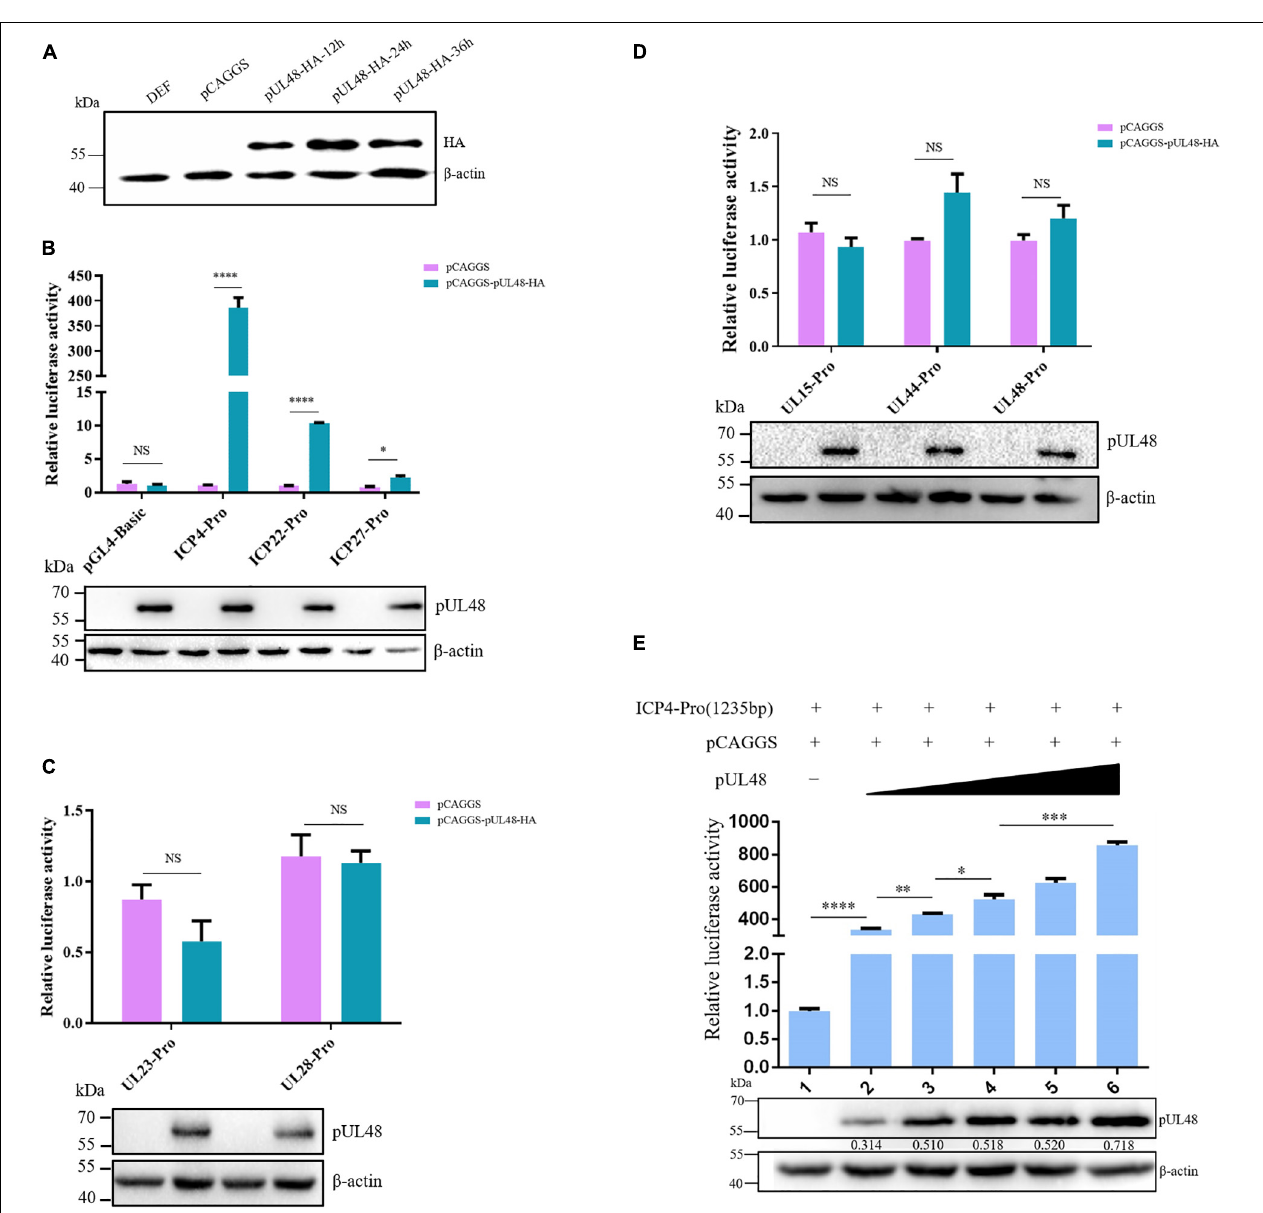
FIGURE 1 | Regulation of pUL48 on duck plague virus (DPV) gene promoters of different types. (A) Expression of pCAGGS-pUL48-HA in DEF. pCAGGS and pCAGGS-pUL48-HA were transfected into DEF, respectively, and cell protein samples were collected at 12, 24, and 36 h for Western blot. (B) The regulation of pUL48 on the IE gene promoter of DPV. (C) The regulation of pUL48 on DPV early gene promoters. (D) The regulation of pUL48 on DPV late gene promoter. (E) Dose-dependent activation of pUL48 on ICP4-Pro (1,235 bp). pGL4-basic, ICP4-Pro-Luc, ICP22-Pro-Luc, ICP27-Pro-Luc, UL23-Pro-Luc, UL28-Pro-Luc, UL15-Pro-Luc, UL44-Pro-Luc, and UL48-Pro-Luc were cotransfected into DEF with pCAGGS, pCAGGS-pUL48-HA, and pRL-TK/0.05, 0.1, 0.2, 0.3, and 0.4 µ g pCAGGS-pUL48-HA were cotransfected into DEF with pCAGGS, ICP4-Pro (1,235 bp)-Luc and pRL-TK. Except for the reference plasmid pRL-TK, the transfection ratio of other plasmids was 1:1:1, and the transfection quantity of pRL-TK was 1/20 of the double luciferase plasmids; pCAGGS was a blank group. Cell samples were collected 24 h after transfection. The activity of each promoter was detected by a dual-luciferase reporting system. The corresponding concentration of pCAGGS-pUL48-HA was transfected into DEF. At 24 h after transfection, cell protein samples were collected for Western blot analysis. Student’s t -test was used to analyze the differences of the two groups. The significance was as follows: NS showed no difference, ∗ p < 0.05, ∗∗ p < 0.01, ∗∗∗ p < 0.001, ∗∗∗∗ p <